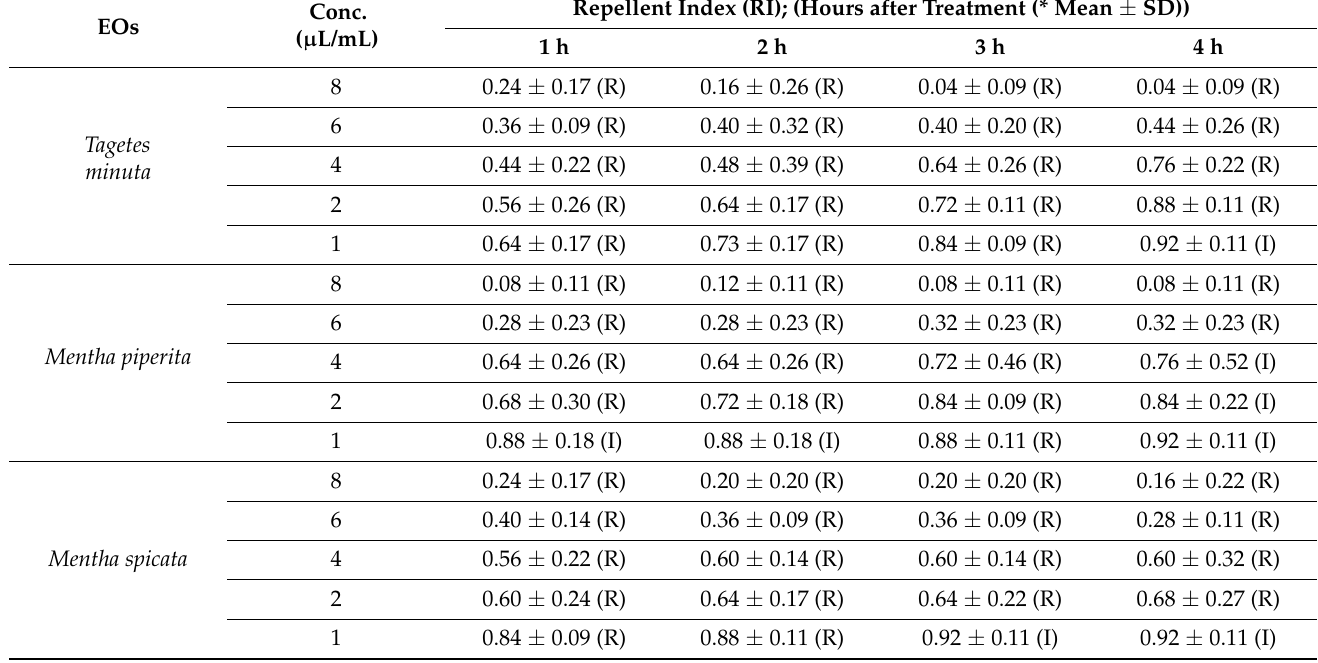
Table 4. Repellent index of essential oils against Callosobruchus chinensis .